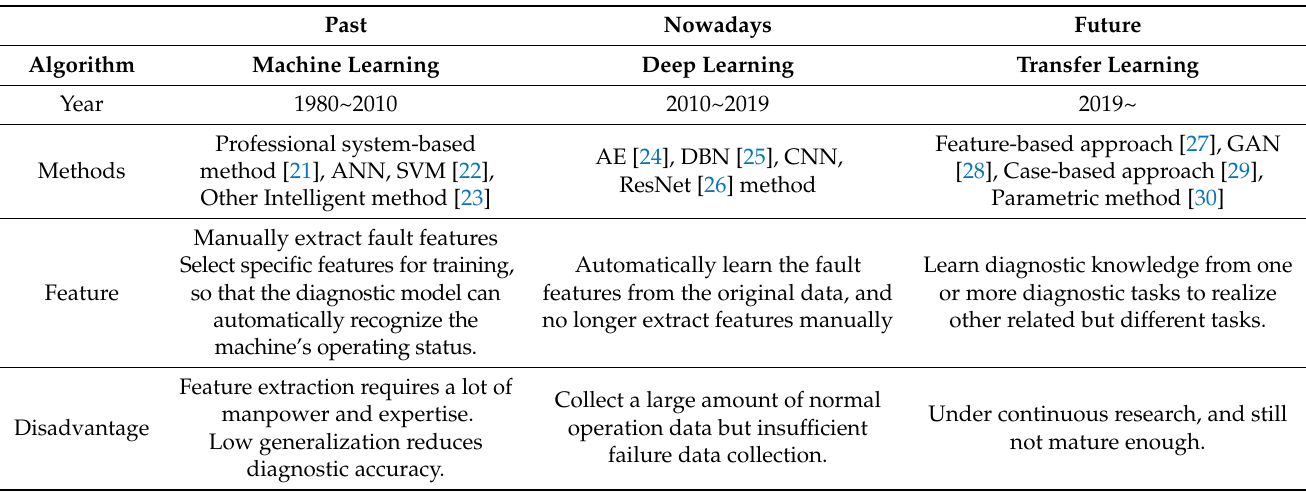
Table 1. Intelligent Fault Diagnosis Technology